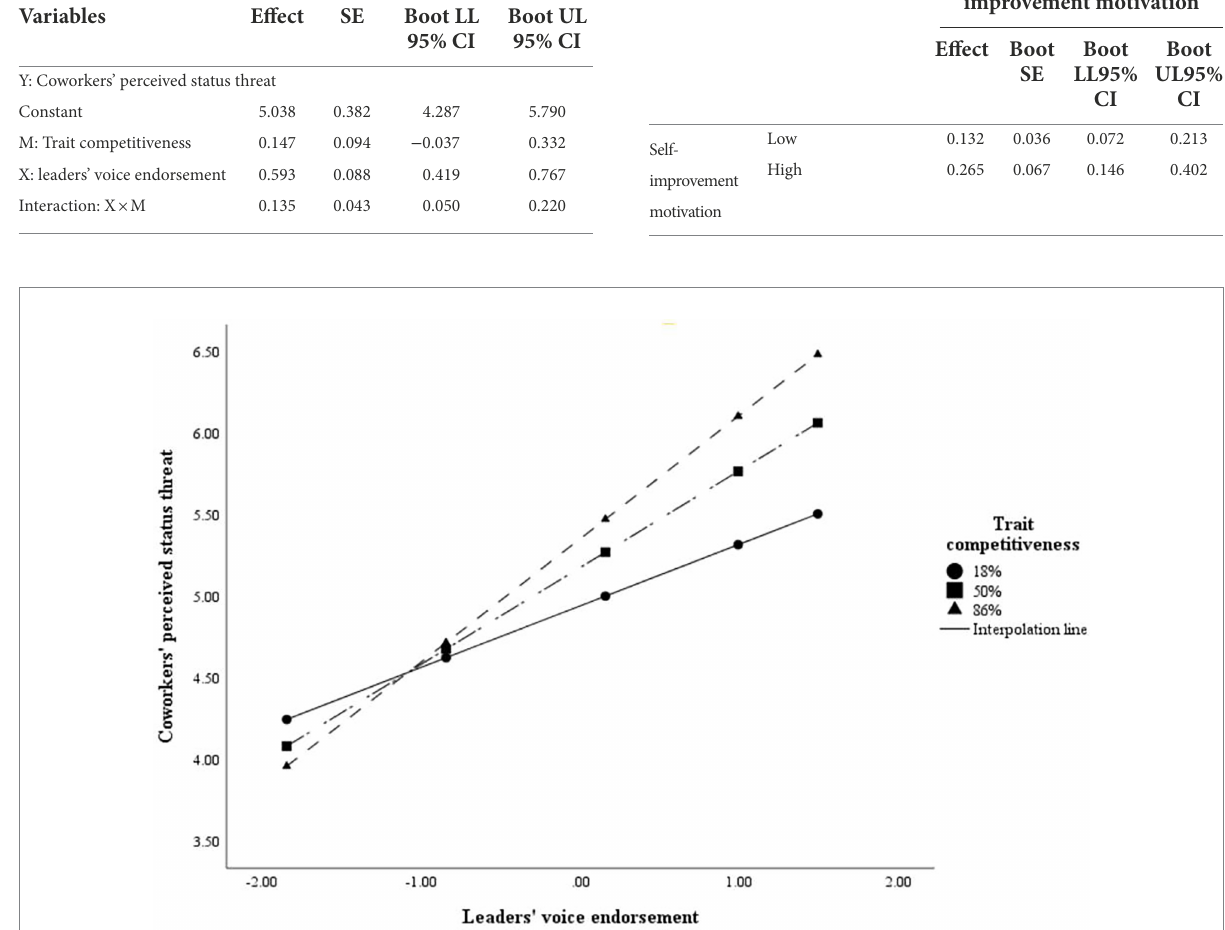
FIGURE 3 Interactive effect of leaders’ voice endorsement and trait competitiveness on coworkers’ perceived status threat.